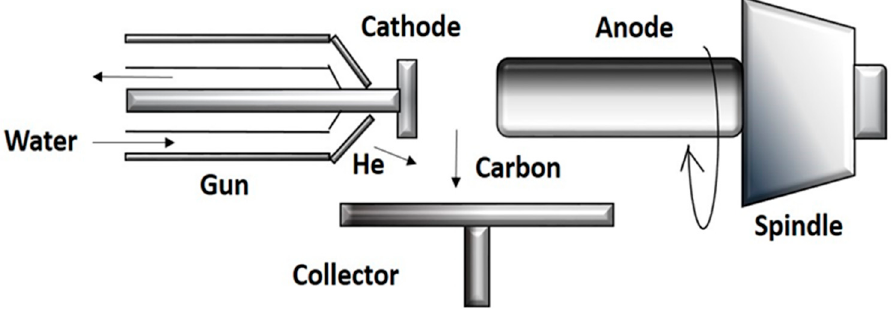
Figure 5. Schematic diagram showing rotating arc discharge.